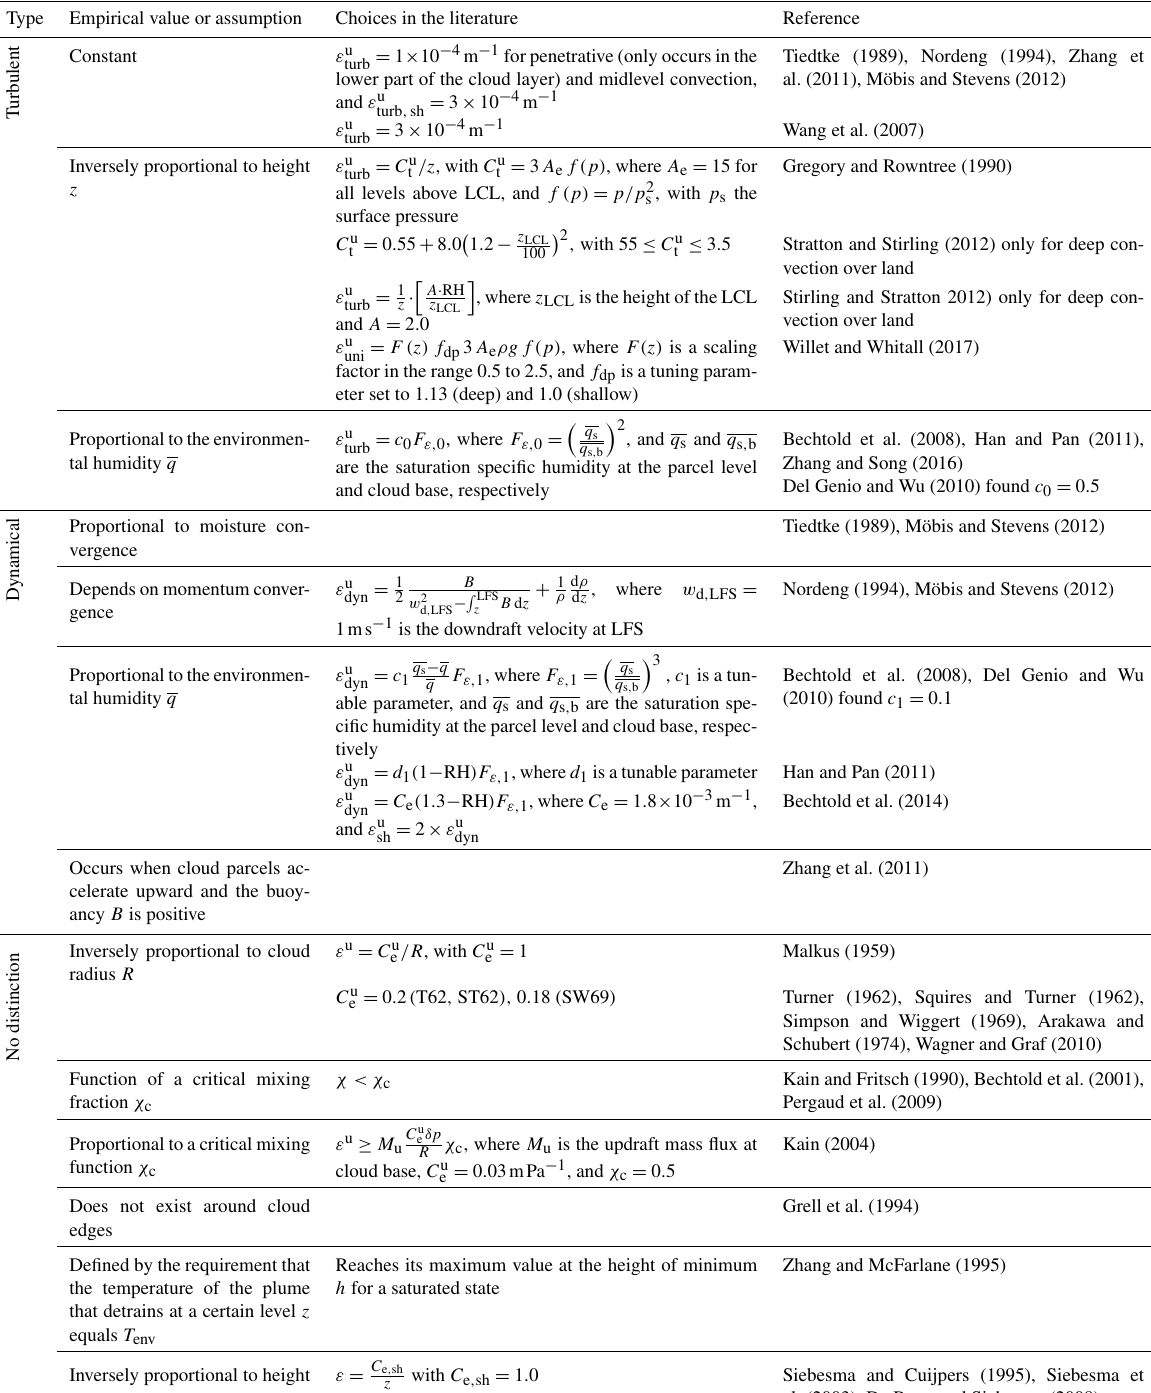
Table 5. A sample of empirical values and assumptions used in the parameterization of entrainment in the updraft (note: subscript “sh” refers to shallow